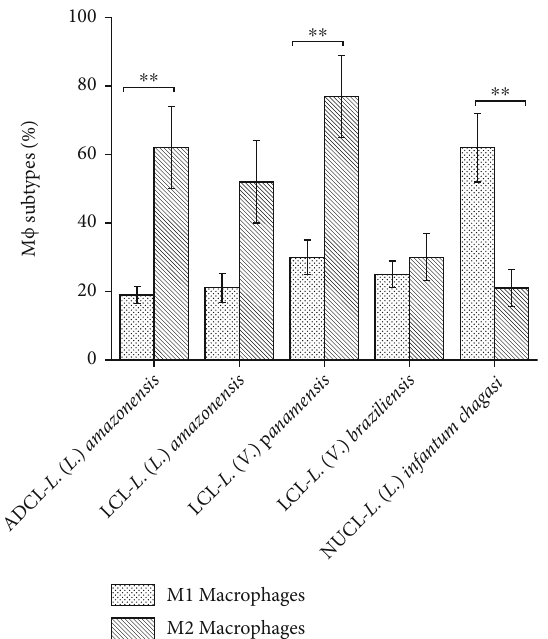
Figure 3: Cellular density ( average ± standard error ) of M1 and M2 macrophages in the skin lesion of di ff erent clinical forms of American cutaneous leishmaniasis, anergic di ff use cutaneous leishmaniasis (ADCL) by L. ( L. ) amazonensis, localized cutaneous leishmaniasis (LCL) by L. ( L. ) amazonensis , L. ( V. ) panamensis , L. ( V .) braziliensis , and nonulcerated cutaneous leishmaniasis (NUCL) by L. ( L. ) infantum chagasi . ∗ P < 0 : 05 ; ∗∗ P < 0 : 01 ; ∗∗∗ P < 0 : 001 .